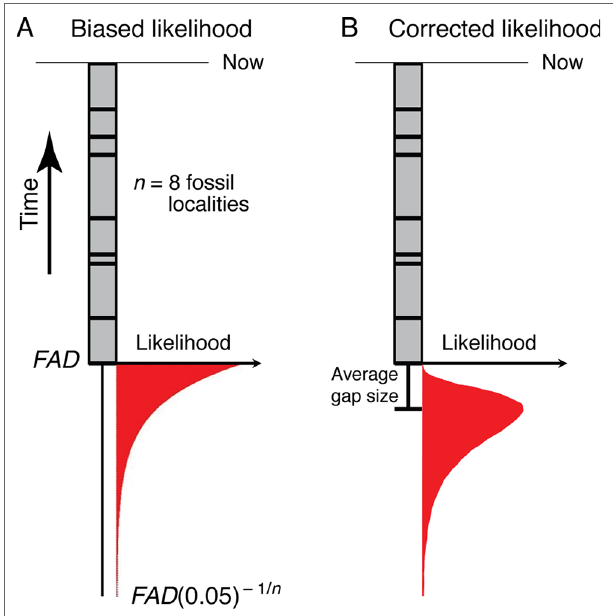
FIGURE 4 | (A) The exponential likelihood density function for how much older the true time of origin of a morphospecies is than its FAD (ΔT Gap ) under the assumption of random fossilization. (B) The likelihood density function in (A) corrected for a finite sample size (see Section 3.1.2).